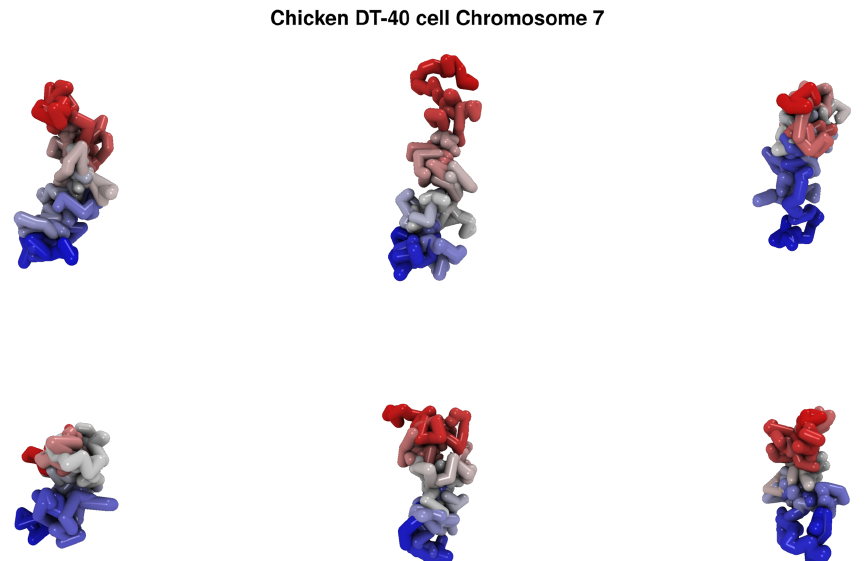
FIG. 17. Individual conformation for chromosome 14 for HeLa cell line at 0, 2, 4, 6, 12 h. Four individual conformations are shown for each time point. Each individual conformation is generated randomly. The colors encode the genomic position of the loci. Red and blue represent the 5 0 and 3 0 ends, respectively.